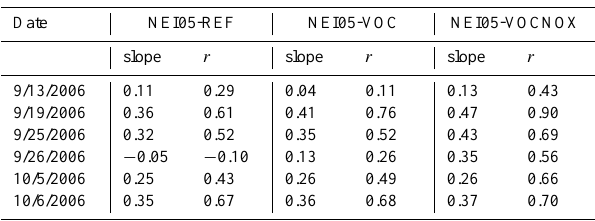
Table 11. Statistics (slope and correlation coefficient r ) from linear fits between observed O 3 ( = x ) and modeled O 3 ( = y ) using the NEI05-REF, NEI05-VOC and NEI05-VOCNOX inventories for the Houston area (defined in Table